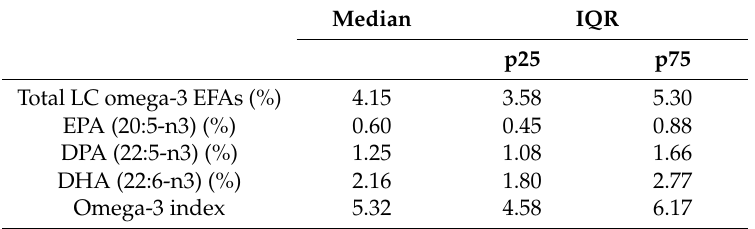
Table 2. Concentration of long-chain omega-3 EFAs present in erythrocytes for the study cohort.